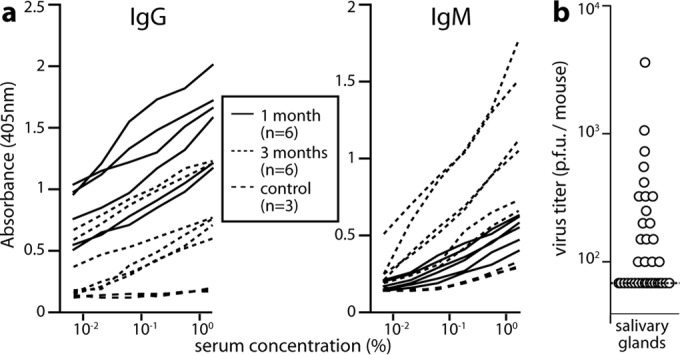
Longer-term MCMV transmission between cohoused BALB/c mice. (a) Alert male and female adult mice were infected nasally with K181 MCMV (105 PFU in 5 µl), then mated as trios with access to nesting materials. Pups were test bled and weaned at 4 weeks, maintained with sex-matched littermates for a further 2 months, and then tested for MCMV infection by ELISA of virus-specific serum IgG and IgM and plaque assay of homogenized salivary glands. Serological results at 1 month and 3 months plus serological results of age-matched controls are shown. Of 36 mice, 26 mice were IgM+. IgG serology was considered less reliable because of the difficulty of distinguishing new responses from residual maternal IgG. Examples of positive responses are shown. (b) The same mice as in panel a were tested for infection by plaque assay of salivary glands at 3 months of age. Of 36 mice, 18 mice had recoverable virus. The circles represent titers for individuals. The dashed line shows the limit of assay sensitivity.